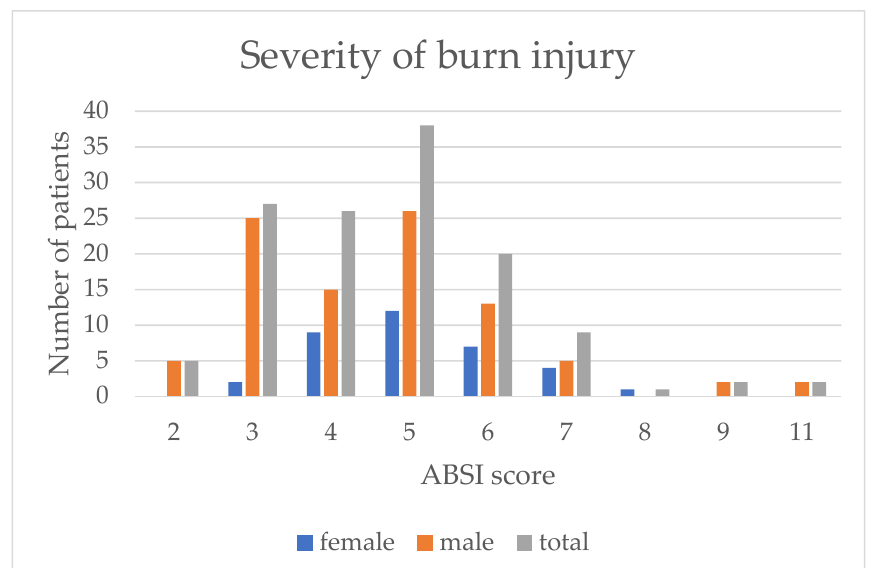
Figure 2. Severity of burn injuries among participants based on the ABSI score by gender.